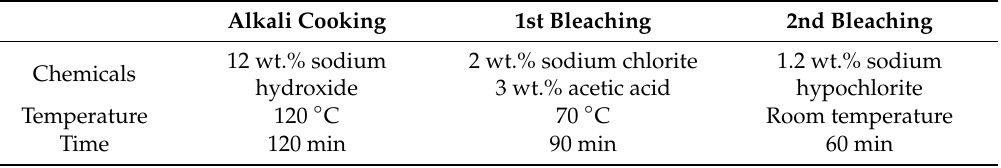
Table 1. Alkali cooking and bleaching condition for the extraction of tall goldenrod cellulose fibers.